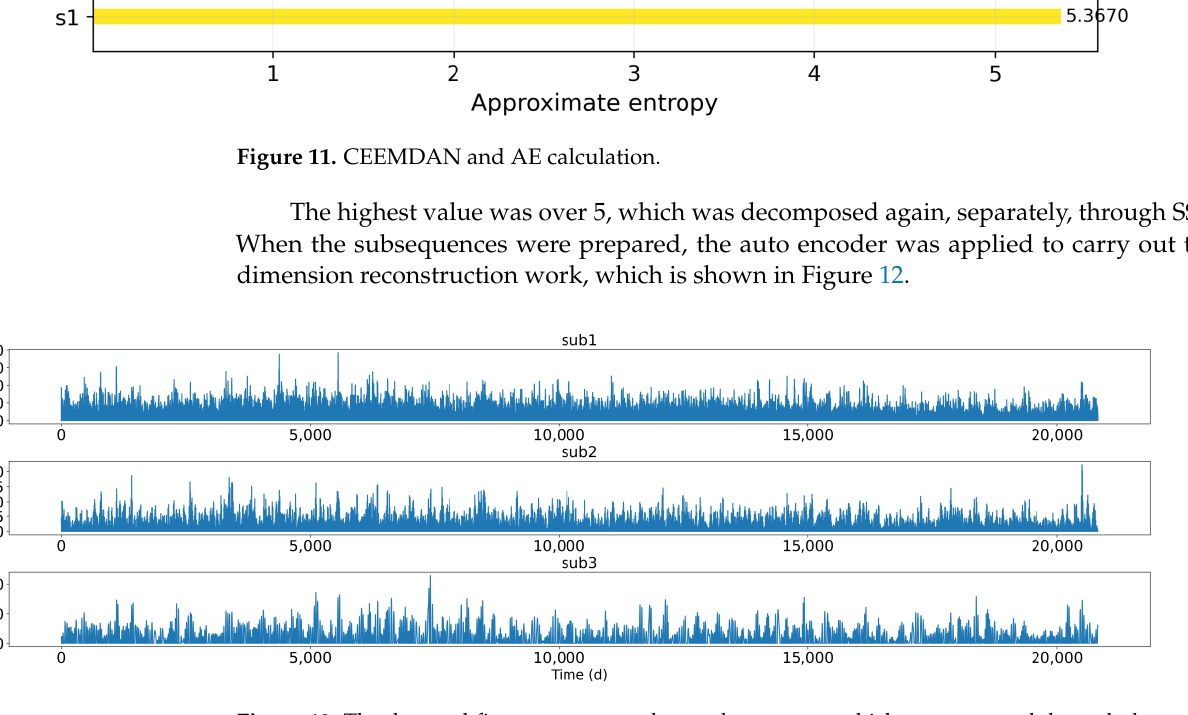
Figure 12. The three subfigures represent three subsequences which are generated through decompo- sition and dimension reduction from the original time series in case